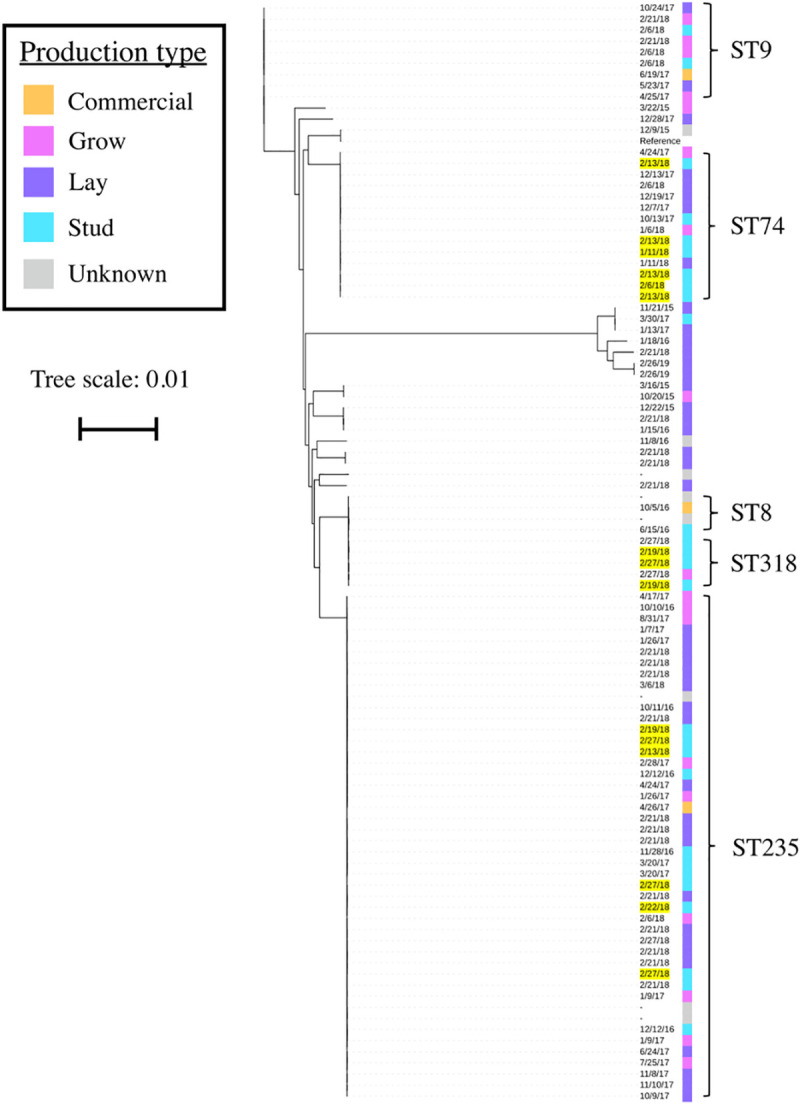
SNV-based phylogeny of P. multocida isolates involved in recurrent fowl cholera outbreaks within the same commercial turkey company.Phylogenetic tree constructed from 100,023 core SNVs of 99 P. multocida genomes. These genomes originated from clinical isolates collected during multiple fowl cholera outbreaks within a single company. The different colors represent different stages of turkey production (see legend). Collection dates are listed, and those highlighted in yellow represent successive samplings from a single indoor flock during an outbreak of fowl cholera in 2018. Clusters of specific sequence types are indicated with brackets. The scale bar represents a branch length of 0.01 (approximately 1,000 SNVs).